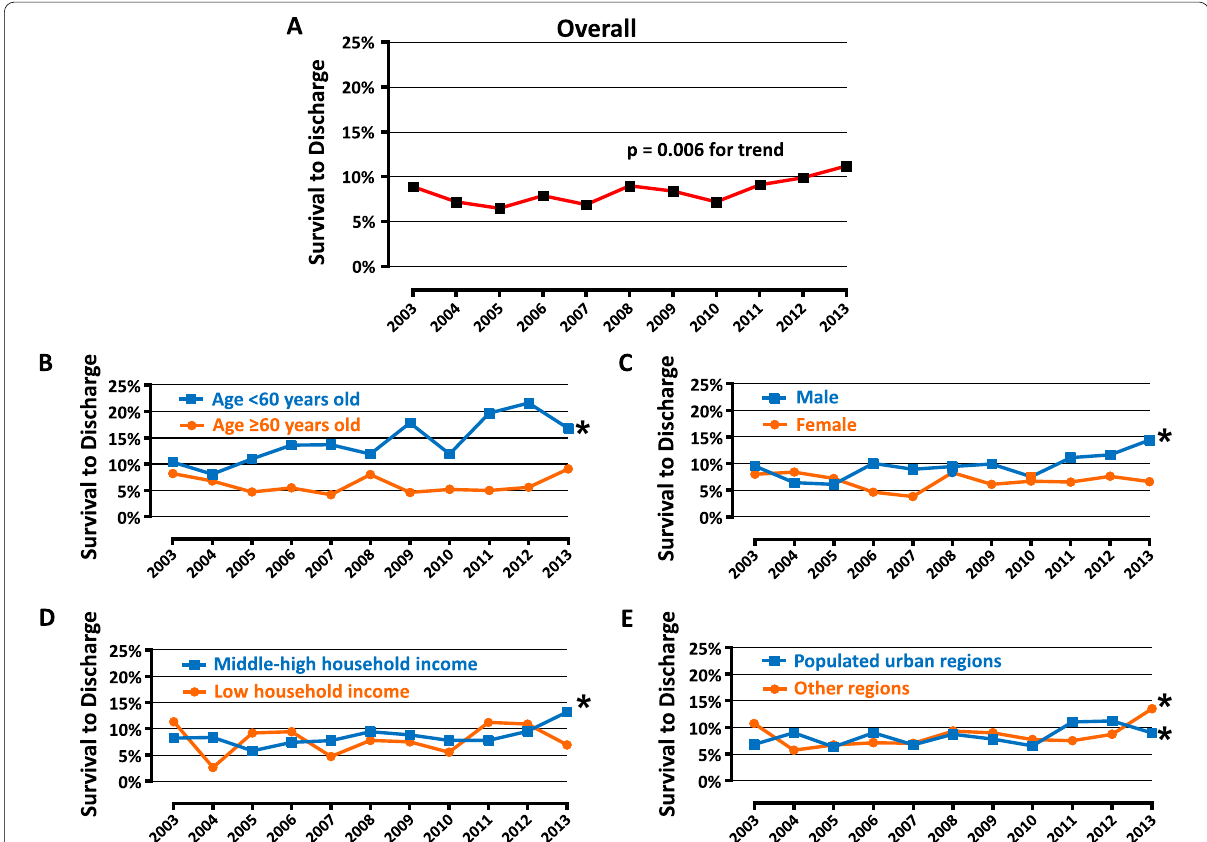
Fig. 3 Survival rate to hospital discharge of sudden cardiac arrests from 2003 to 2013, including the total ( a ) and According to the age ( b ), Gender ( c ), Household income ( d ), and Region by urbanization ( e ). * p